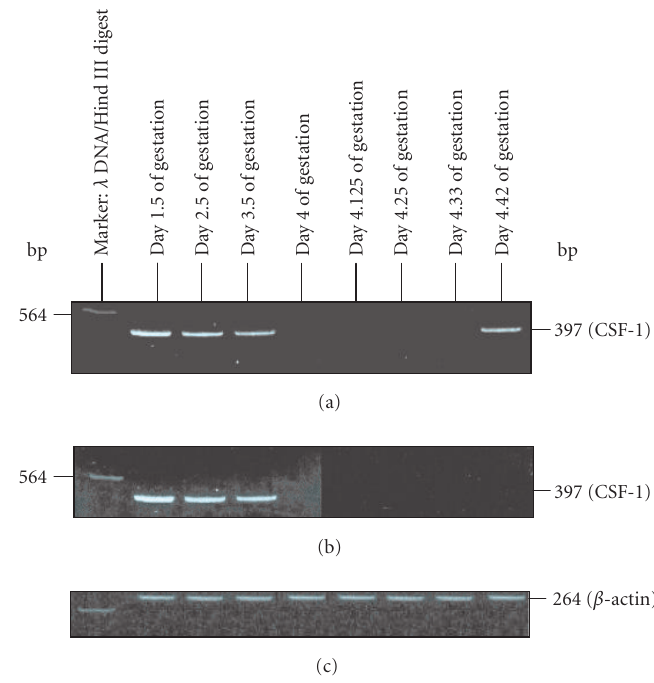
Figure 3: Detection of CSF-1 mRNA transcripts in the preimplantation mouse embryos collected from (a) LPS-treated animals and (b) control animals at the di ff erent stages of preimplantation period of pregnancy by RT-PCR. Pannel (c) shows a representative picture showing uniform expression of β -actin used as an internal control.